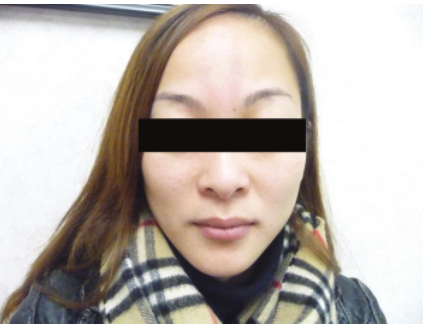
Figure 1: A faint erythematous patch noted on the forehead and glabellum of a 33-year-old